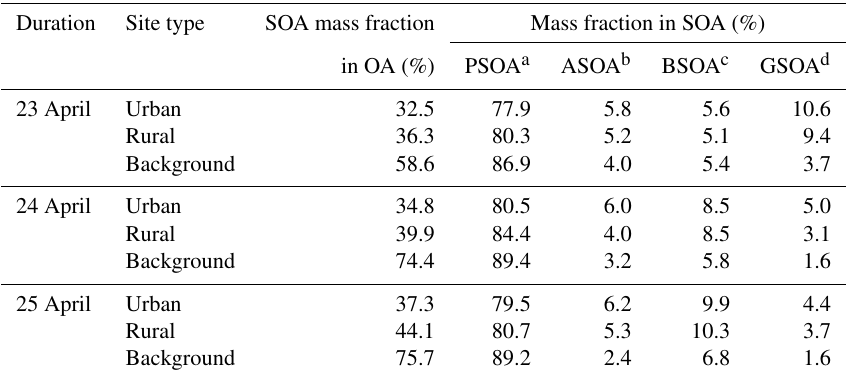
Table 4. Simulated mass fractions of SOA in the total OA, and the SOA contribution from various formation pathways averaged over the simulation period at urban, rural, and background